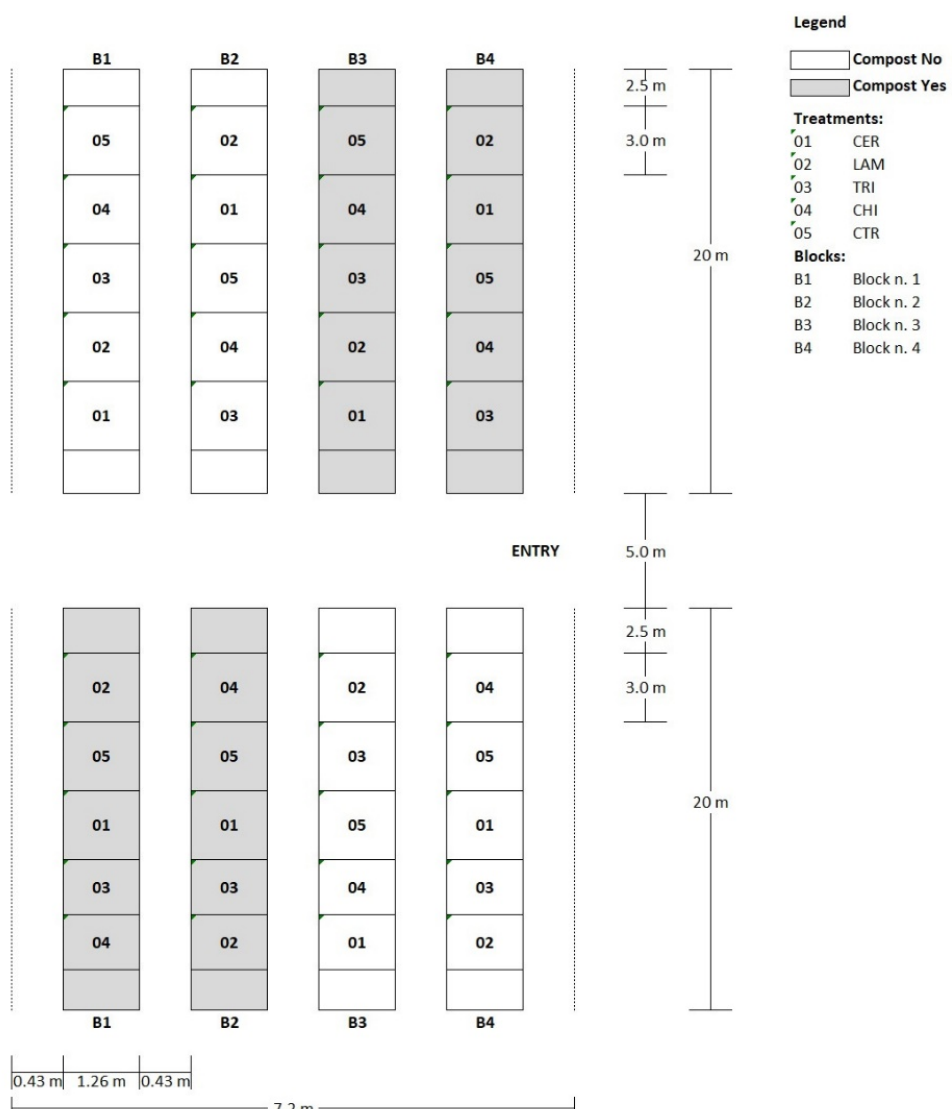
Figure 2. Experimental design of the two-way split-plot field trial carried out under a multi-tunnel greenhouse located at the CREA-Research Center for Vegetable and Ornamental Crops.